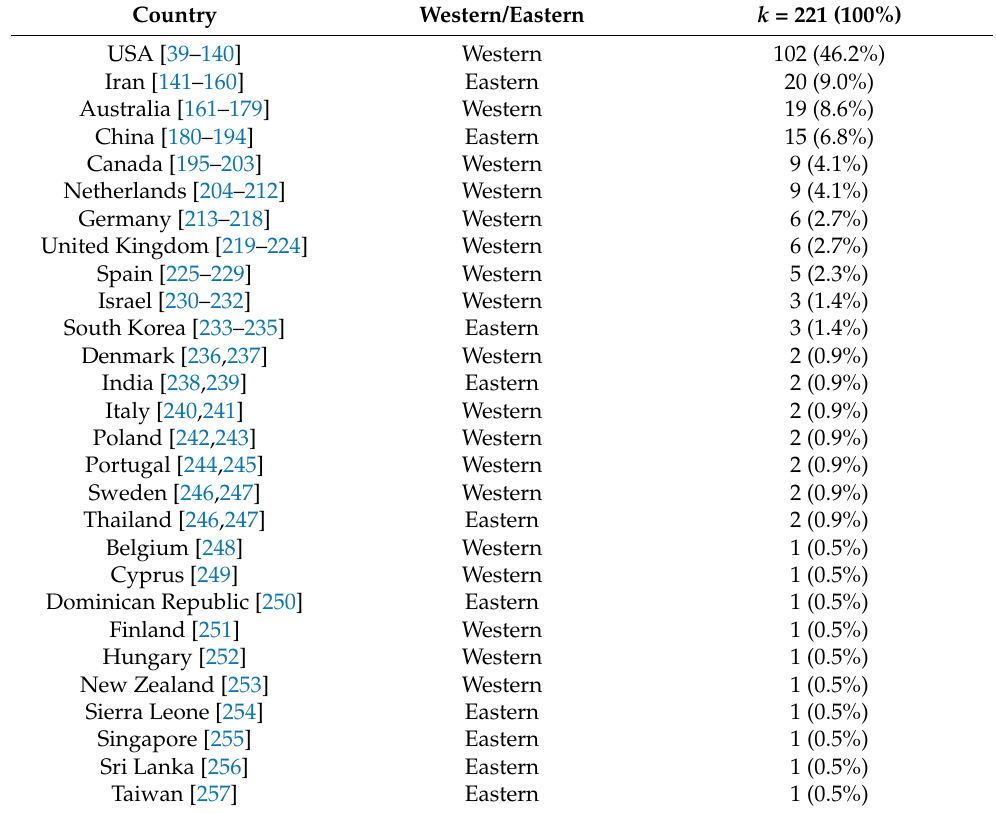
Table 1. Overview of the countries the studies were conducted